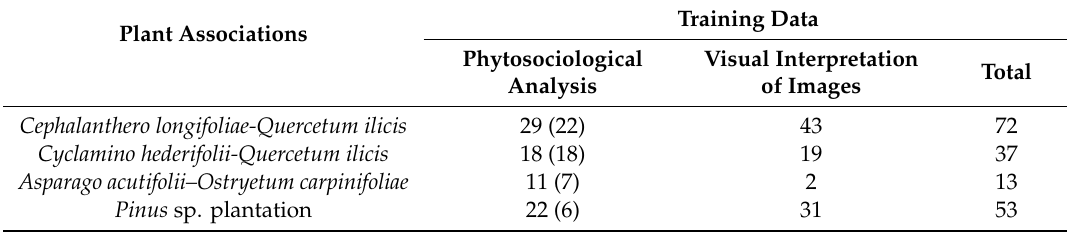
Table 2. Reference data used for training. Number of plot references for plant associations acquired by field phytosociological analysis (in parenthesis the number of plots analyzed by phytosociological relev é s) and visual interpretation of high-resolution